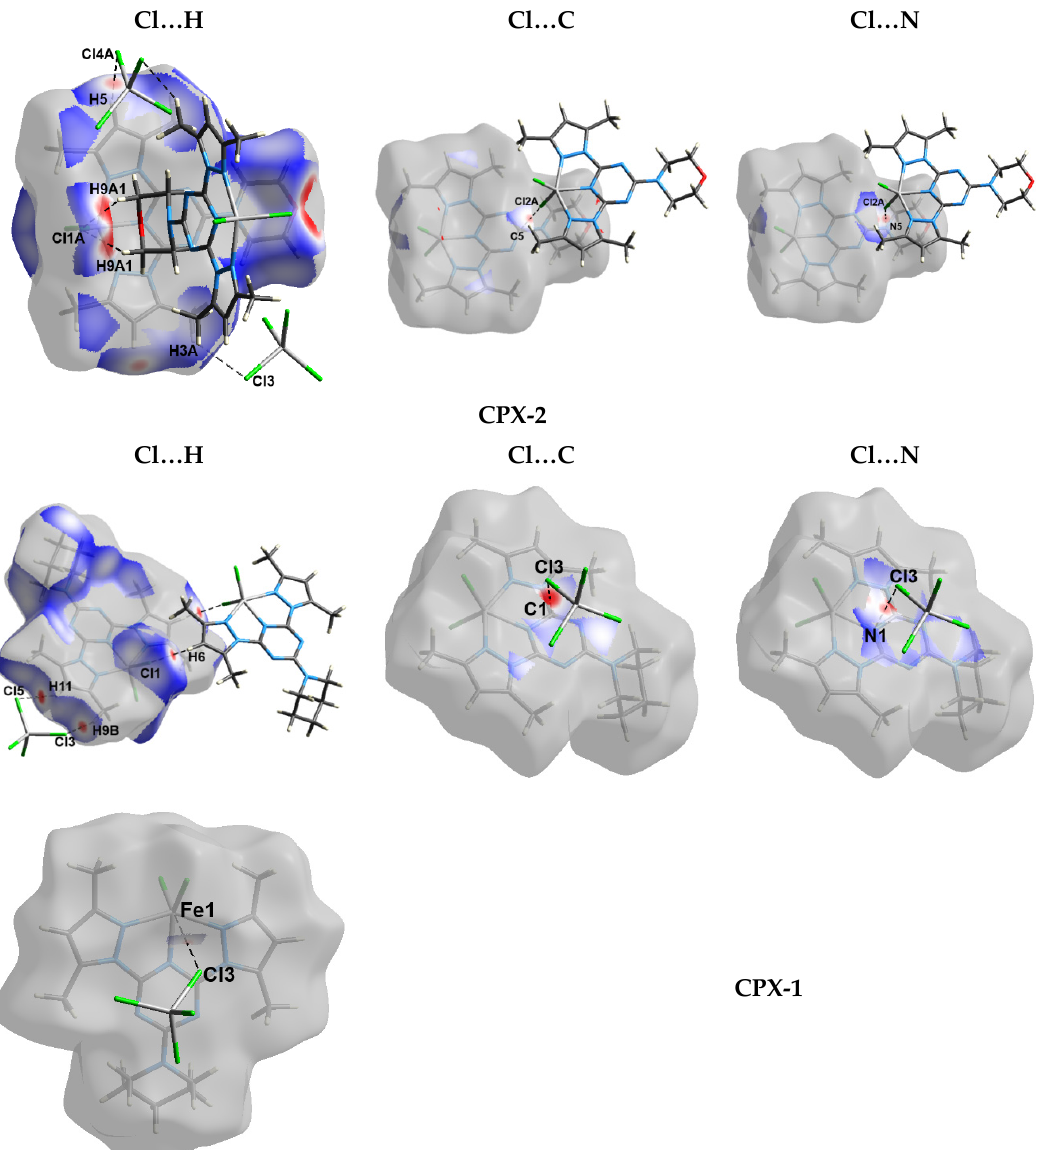
Figure 7. The decomposed d norm maps and fingerprint plots of the most important contacts in 1 and 2 .